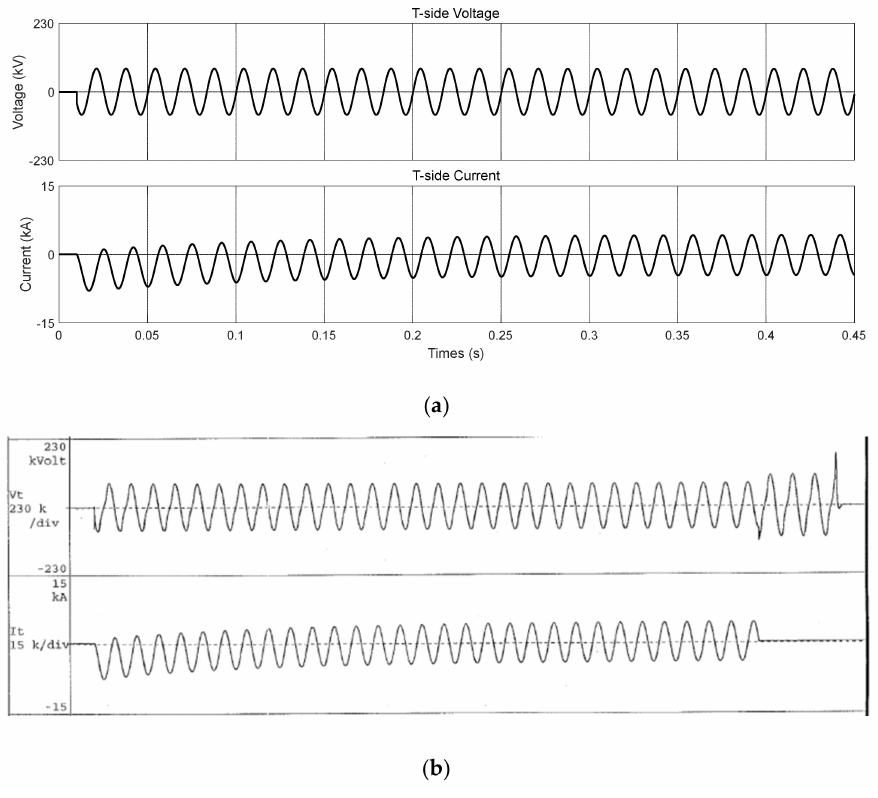
Figure 14. T-phase short-circuit test result of Scott transformer (comparison between short-circuit test results obtained by RTDS and those in the certified test report by KERI): ( a ) waveform of the short-circuit test result of the proposed Scott transformer (T-phase); ( b ) waveform in the certified test report (T-phase).